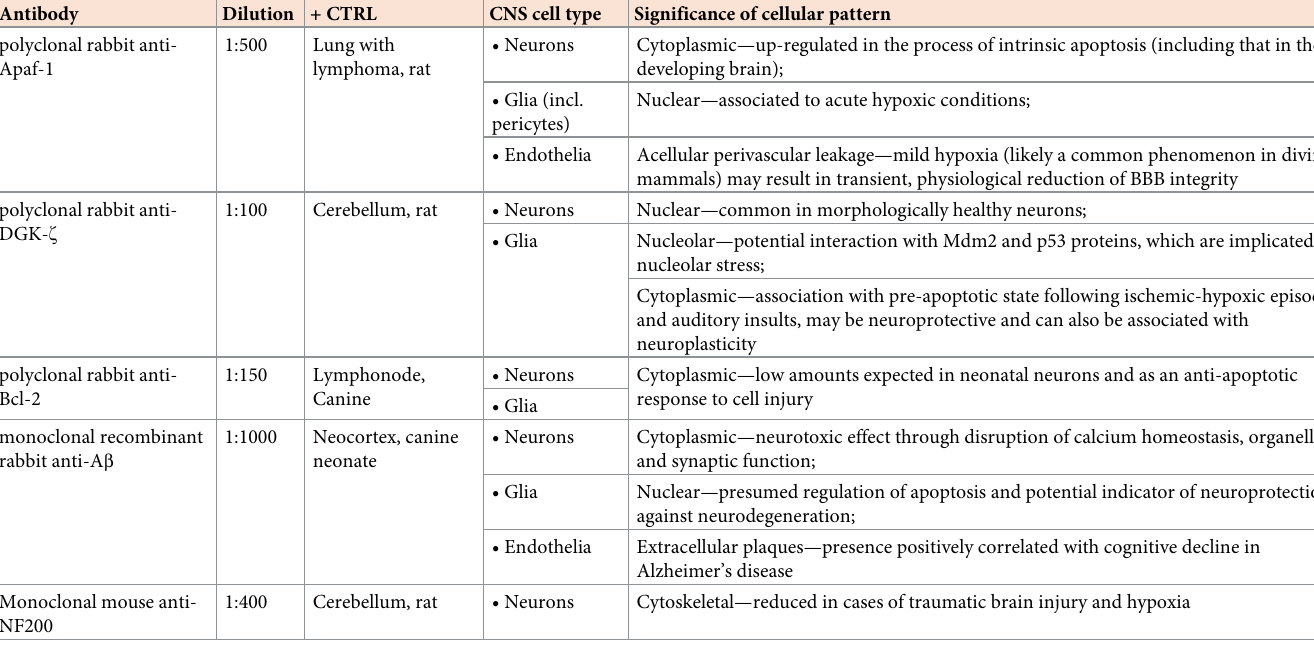
+CTRL: Positive control tissue. BBB: Blood-brain